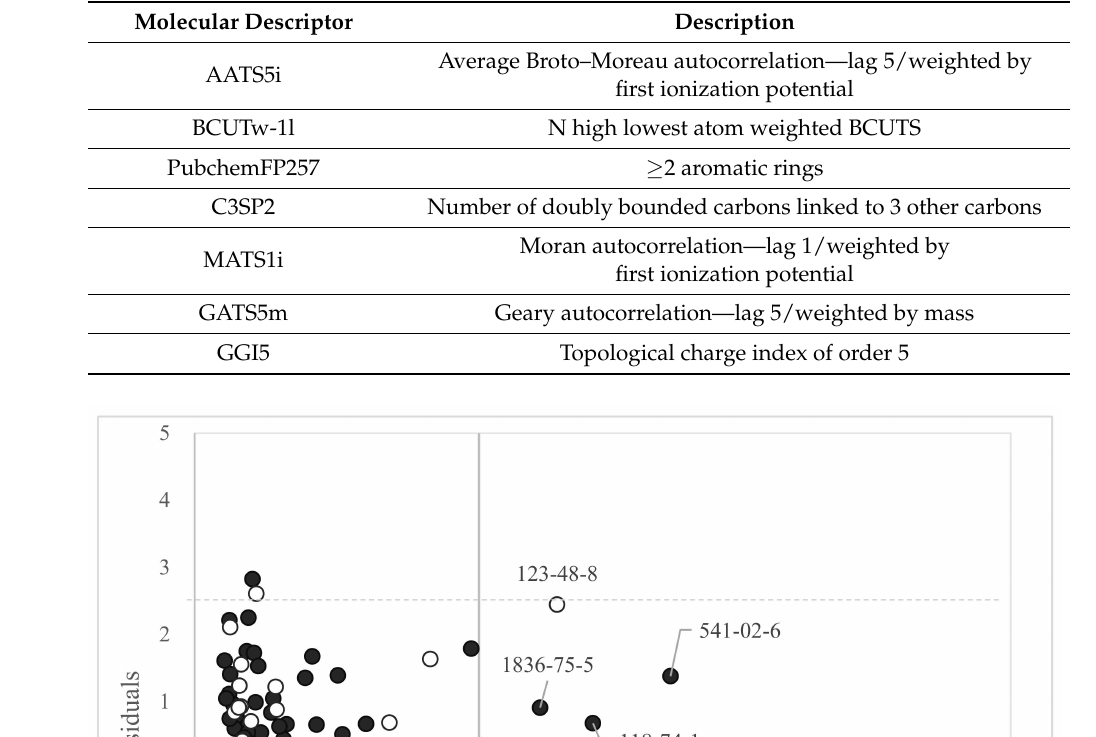
Table 2. List of the molecular descriptors included in Equation (1) and short description.